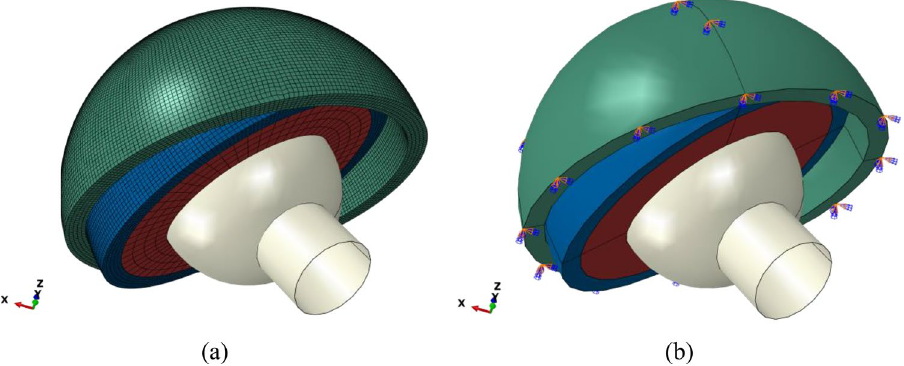
Figure 3. ( a ) Mesh of the model and ( b ) boundary condition for the case of a dual-mobility hip joint prosthesis.